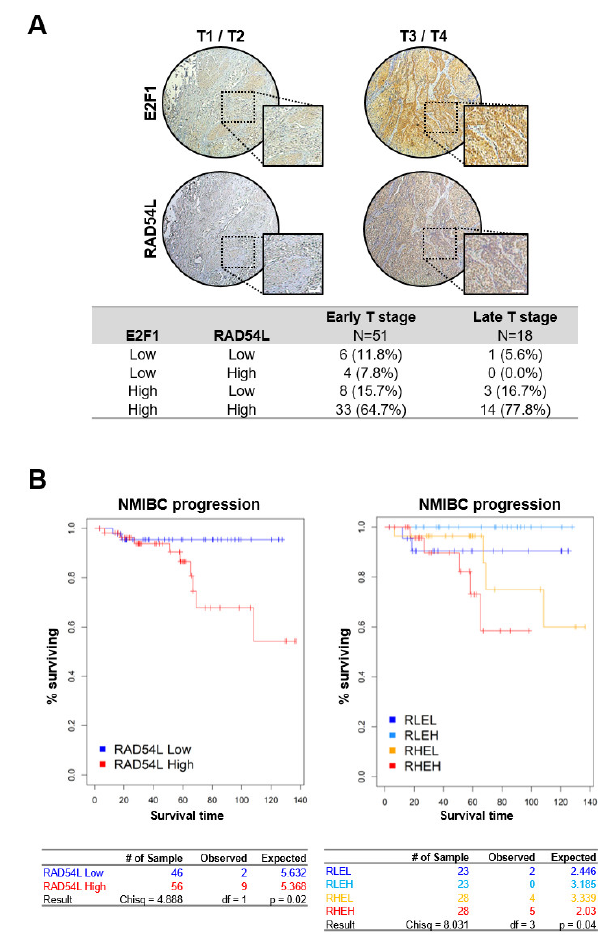
Figure 6. E2F1 and RAD54L expression levels are correlated with cancer progression in BLC patients. ( A ) Immunohistochemical analysis of early and late T stage BLC tissues was performed to detect E2F1 and RAD54L expression in representative patient samples. Scale bar: 100 µ m. ( B ) Progression-free survival in NMIBC patients (GSE13507, n = 102, P = 0.02 by log-rank test, left panel). Progression-free survival in NMIBC patients (GSE13507, n = 102, P = 0.04 by log-rank test, right panel). RLEL, RAD54L low and E2F1 low; RLEH, RAD54L low and E2F1 high; RHEL, RAD54L high and E2F1 low; RHEH, RAD54L high and E2F1 high.